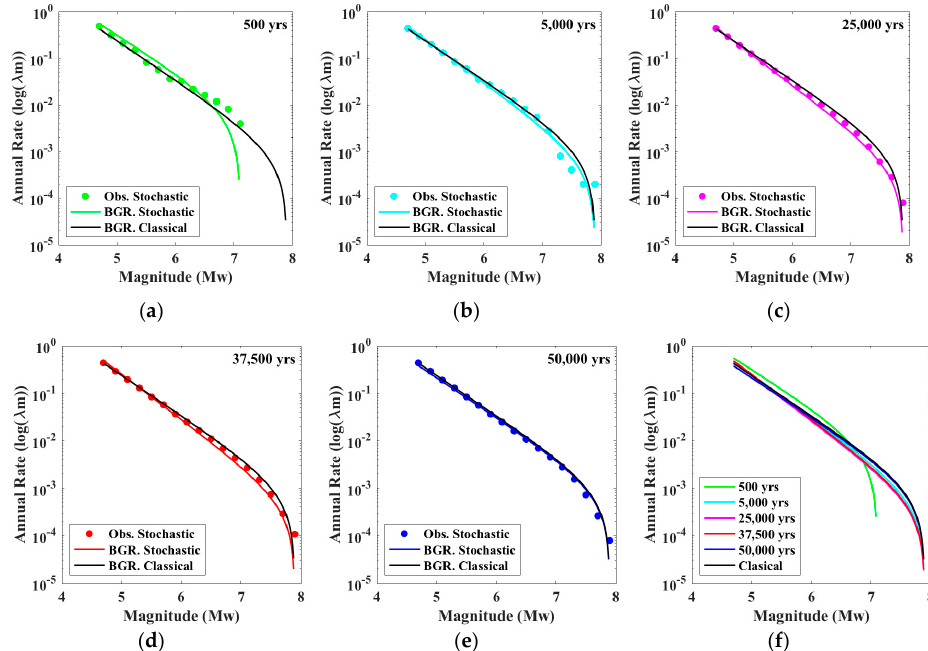
Figure 5. ( a – e ) Truncated Gutenberg-Richter recurrence models derived from five different stochastic catalog lengths (500, 5000, 25,000, 35,500, and 50,000 years), compared with the original recurrence model of the source zone GRAS390 in the SHARE model. ( f ) The 5 recurrence curves obtained are superimposed to the original recurrence